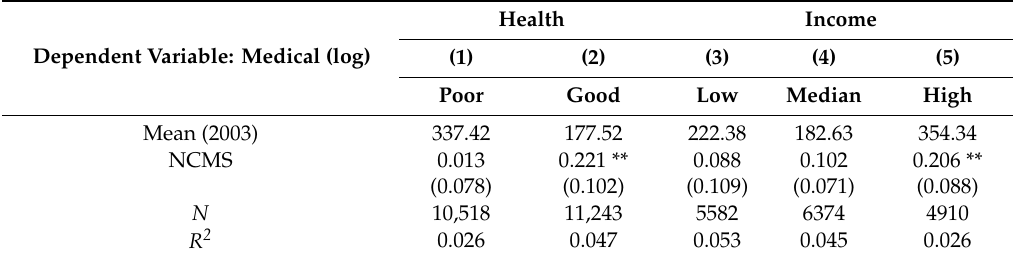
Table 6. E ff ects of NCMS among Di ff erent